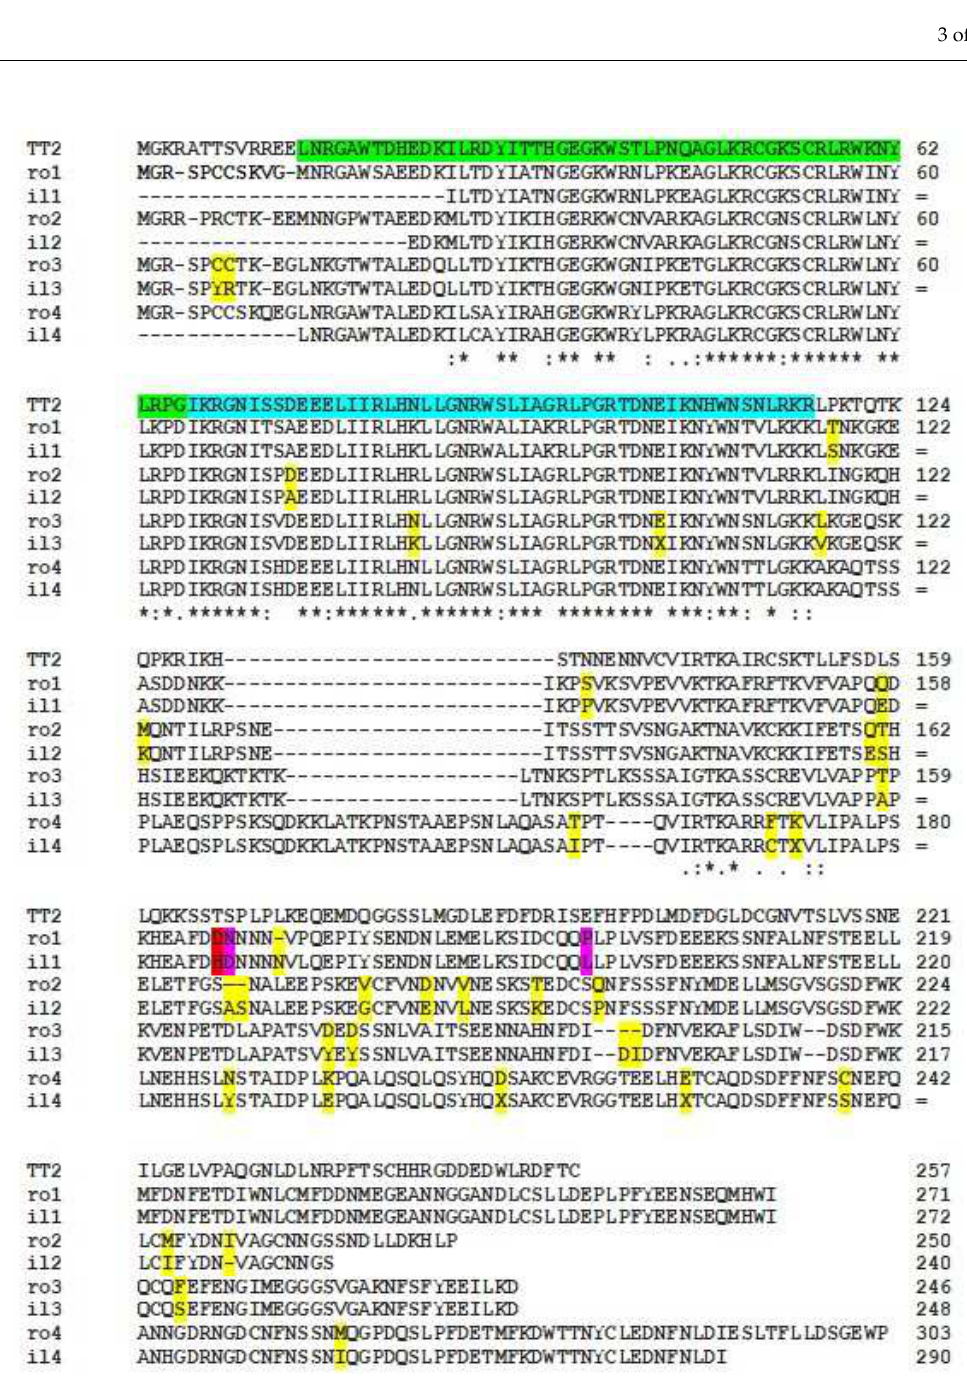
Figure 1. Comparative analysis of Quercus MYB-like proteins. Blastp identified four homologs (Qrob_P0344270.2, Qrob_P0660350.2, Qrob_P0304670.2, and Qrob_P0304630.2) in the Q. robus genome assembly PMN1 (haploid, Pseudomolecule + unassigned scaffolds; urgi.versailles.inra.fr/blast/, accessed on 6 December 2022) by using the TT2 sequence from A. thaliana (Q9FJA2) and, after the design of specific primers (Table 1) and PCR amplification, the four homologs from Q. ilex were identified and sequenced (QiMYB-like-1 D165 allele, QBI90131; QiMYB-like-1 H165 allele, QBI90132; QiMYB-like-2, QBI90133; QiMYB-like-3, QBI90134; QiMYB-like-4, QBI90135). Green/blue, predicted R2/R3 repeats ([6] and references therein); yellow, polymorphisms between Q. robur and Q. ilex sequences; pink+red, polymorphisms between Q. robur and Q. ilex sequences and also between QiMYB-like-1 and QiMYB-like-2 haplotypes; red, polymorphism D165H detected by RFLP (Figure 2). Clustal symbolizes identity (*), strong conservation (:) or weak conservation (.) among aligned protein